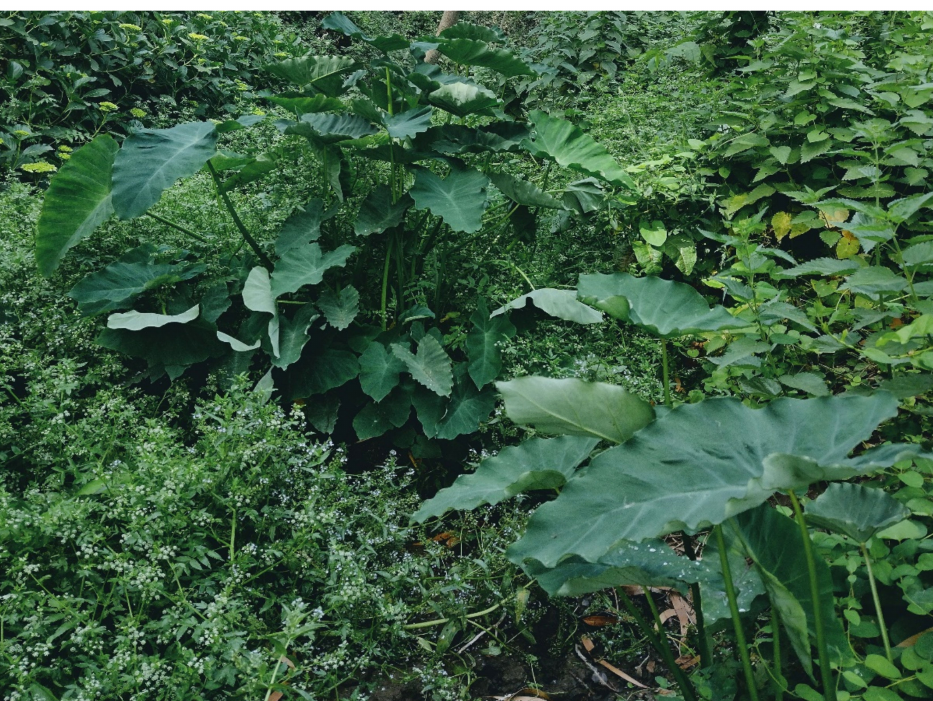
Figure 76. Colocasia esculenta along channel Acqua Mariana (Acquedotti locality). Lemna minuta Kunth : this South American species was first discovered in the Latium region based on collections made in 2007, of which one refers to the Caffarella valley [105]. I am continuing to control the various populations, founding many others both in Caffarella valley and in other parts (mostly in Acquedotti and Tor Marancia localities) where the abundance of the autochthonous L. minor decreased over time. Note that the populations of L. minuta even survived well through snowfall (Figure 77).